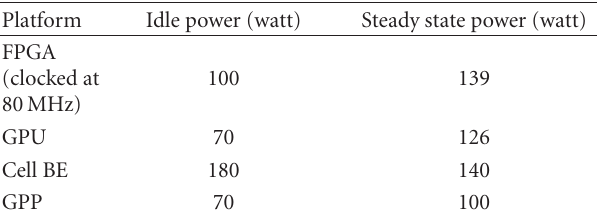
Table 11: Performance per $ and per watt for each technology using the GPP implementation of [21] and GPU implementation of